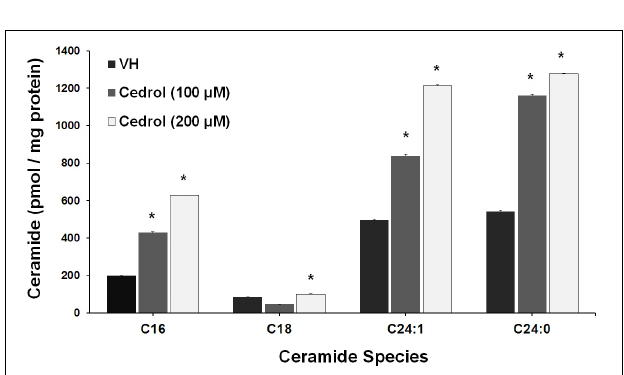
FIGURE 6 | Cedrol enhanced ceramide production in K562 cells. K562 cells treated with VH and cedrol for 18 h. Protein was isolated, and a total of 200 µ g protein lysates was used for ceramide species quantification. Levels of C16, C18, C24, C24:1, and C24:0 ceramide species were determined by LC-MS/MS. Data are mean ± SD of three independent experiments. * P vs. VH (vehicle